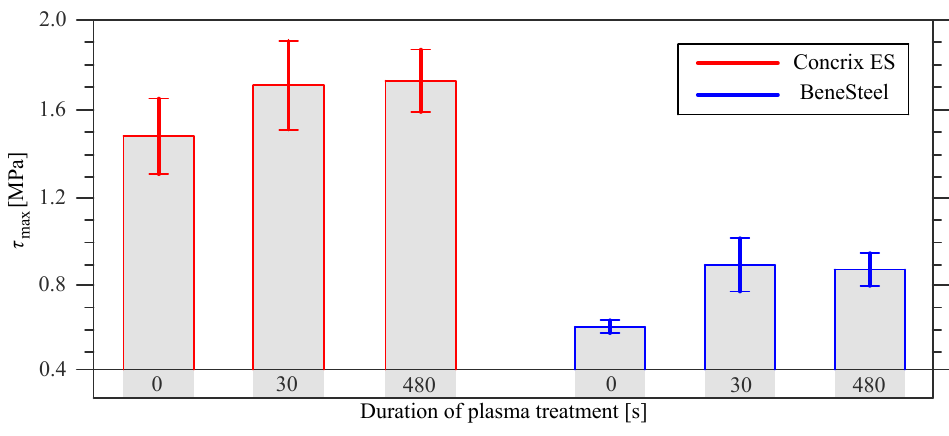
Figure 5. Maximal interfacial shear stresses for various treatment duration.